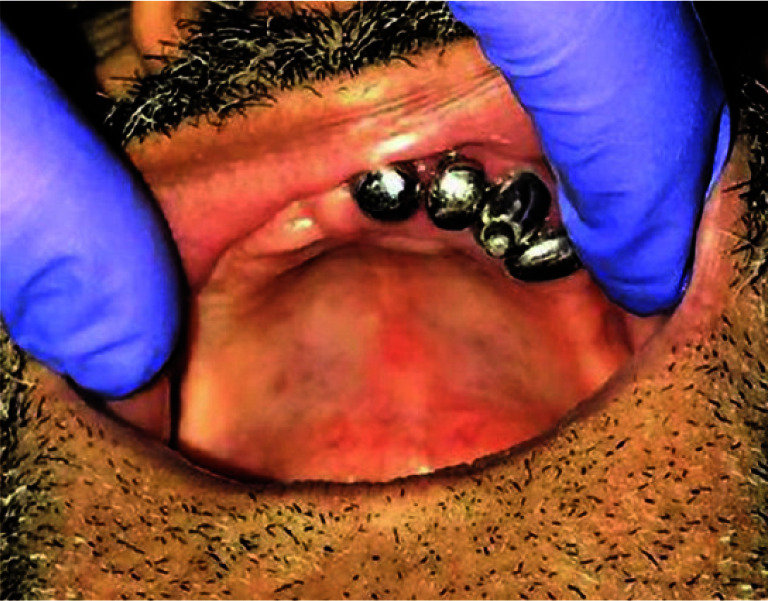
 Erythema after treatment with ZM